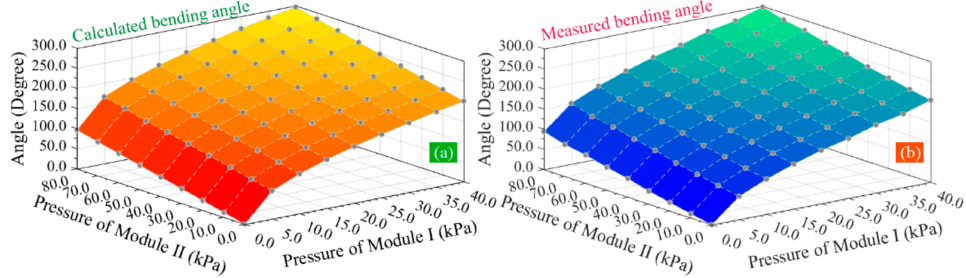
Figure 10. The bending angle of the soft actuator under different pressures: ( a ) the calculated bending angle and ( b ) the measured bending